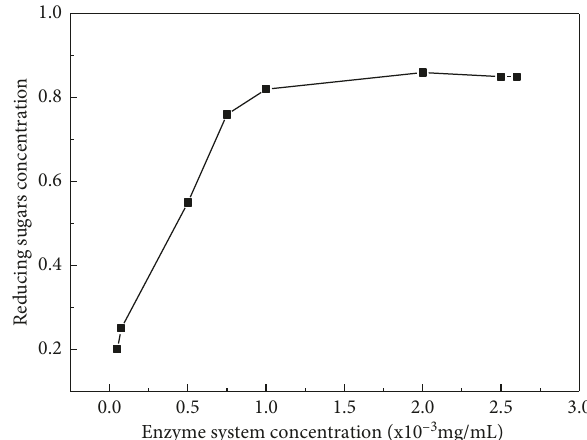
Figure 3: Reducing sugars concentration measures the synergic effect of the complex; up to 2.75